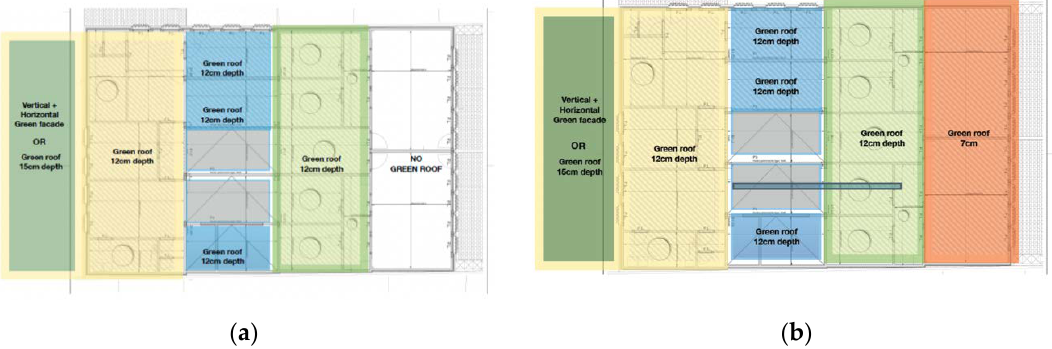
Figure 2. Design drafts for Stadslab2050 case study Elief Playhouse Antwerp: ( a ) Planning Variant A and ( b ) Planning Variant B ( © Dusty Gedge / Green Infrastructure Consultancy).